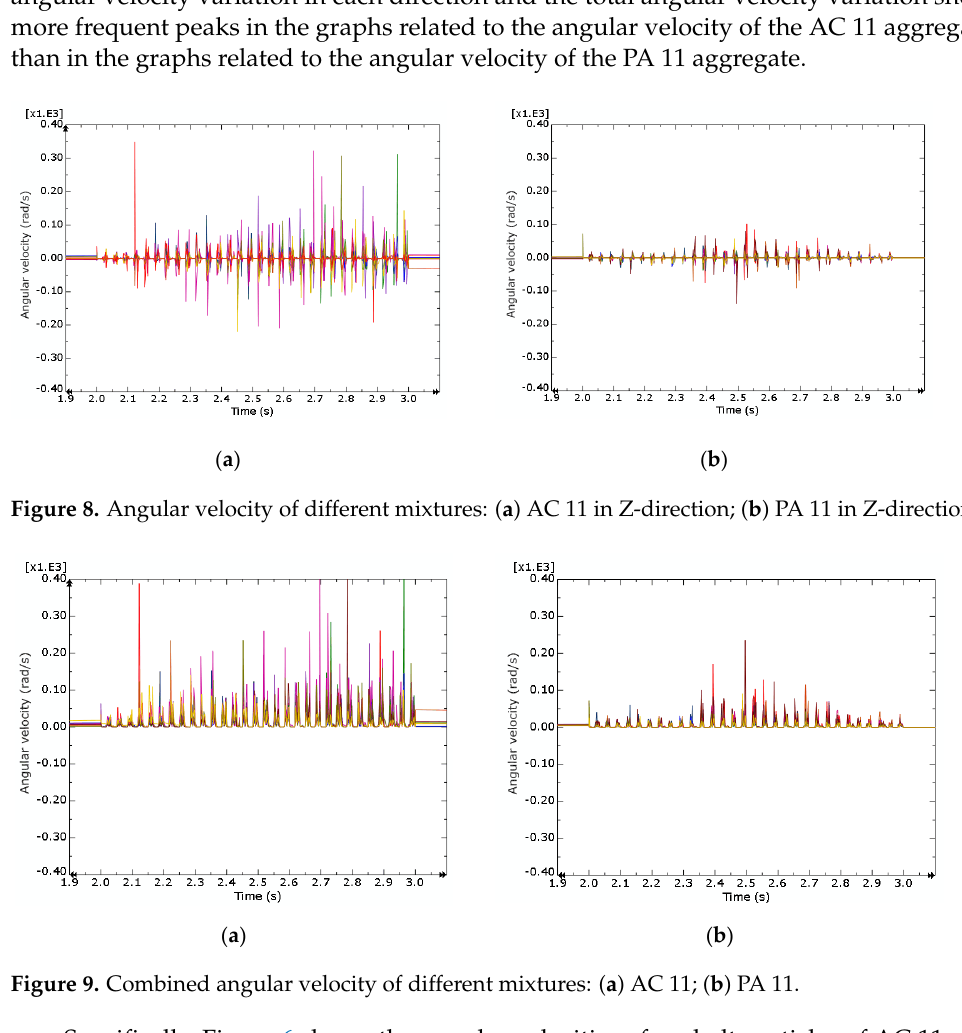
Figure 9. Combined angular velocity of different mixtures: ( a ) AC 11; ( b ) PA 11.